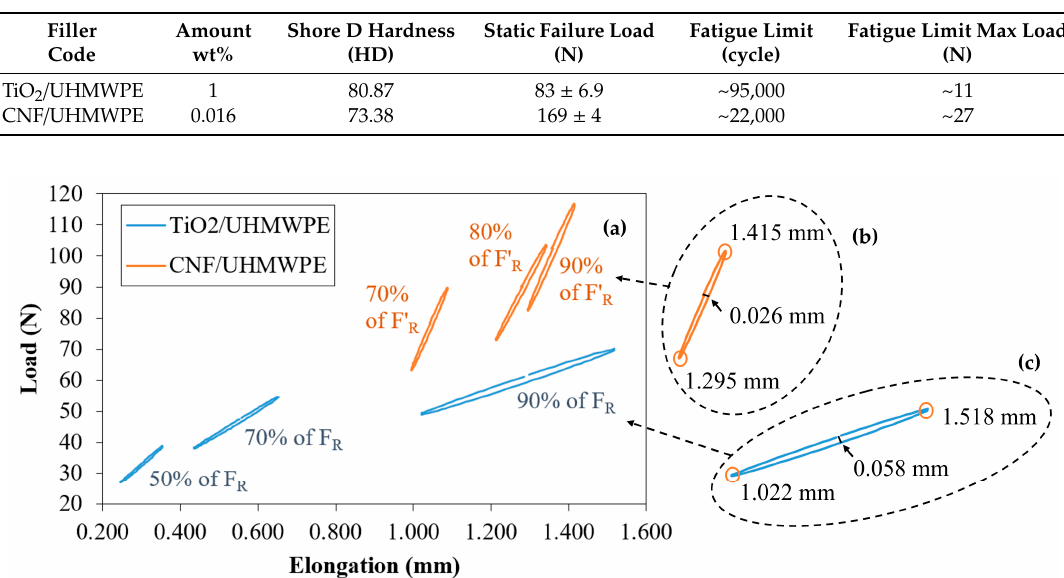
Figure 7. Comparison of the typical hysteric cycles of SLJ filled with CNF / UHMWPE (50 cycles) and TiO 2 / UHMWPE samples (100 cycles) ( a ), with a magnification of the cycle at 90% of F’ R for CNF / UHMWPE samples ( b ) and of the cycle at 90% of F R for TiO 2 / UHMWPE ( c ). Table 3. Comparison of the static and dynamic performance of the TiO 2 /UHMWPE and CNF/UHMWPE samples. The values of the fatigue properties are indicative. CNF/UHMWPE dynamic characterization is reported in [21].